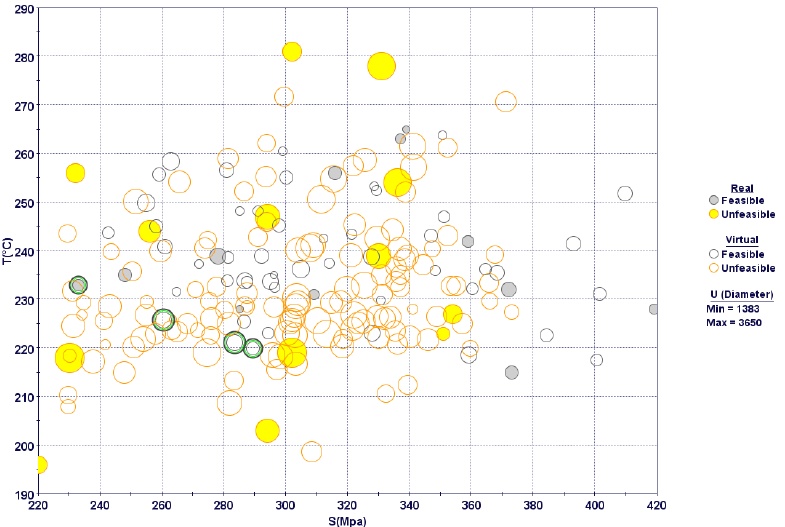
Figure 12. Three-dimensional bubble chart showing design points after optimization search (Green circles represent optimum design points).